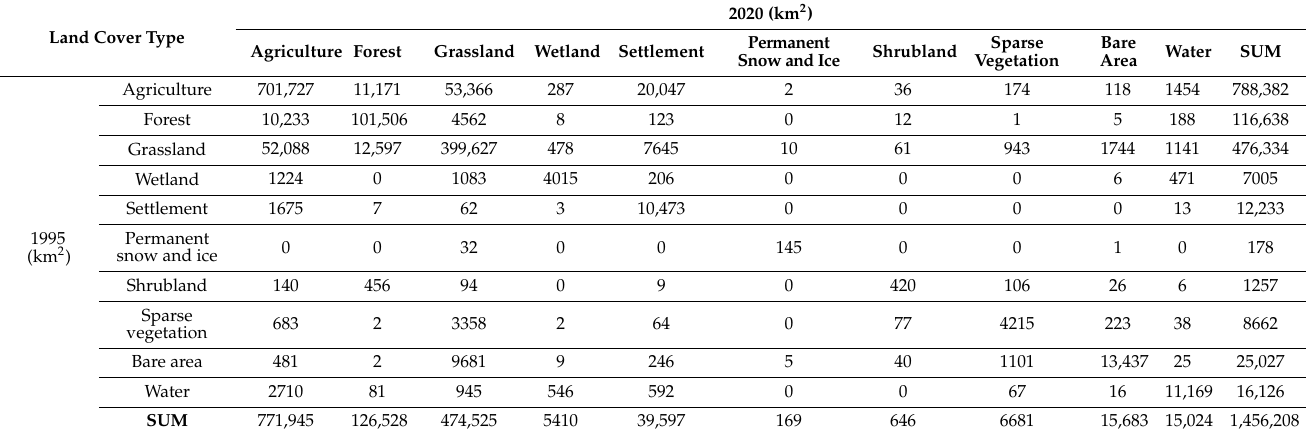
Table A1. Area transfer matrix between land cover in 1995 and land cover in 2020.